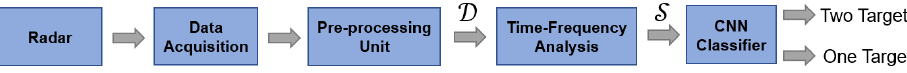
Figure 3. Block diagram of the proposed system.